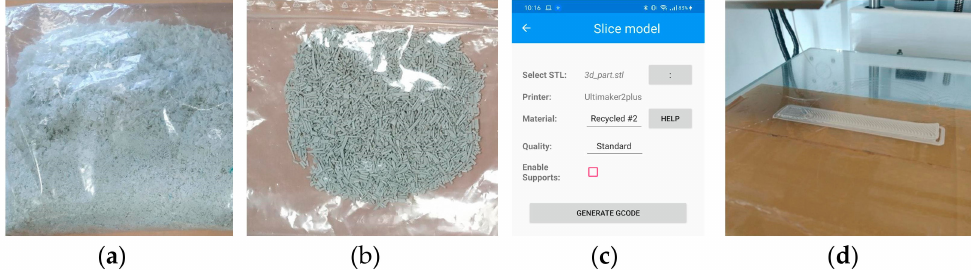
Figure 7. Strapping tape recycling experiment: ( a ) Shredded strapping tape from the waste; ( b ) result of a second shred; ( c ) end-user application; ( d ) warping effect of the strapping-tape-based material during printing trials.